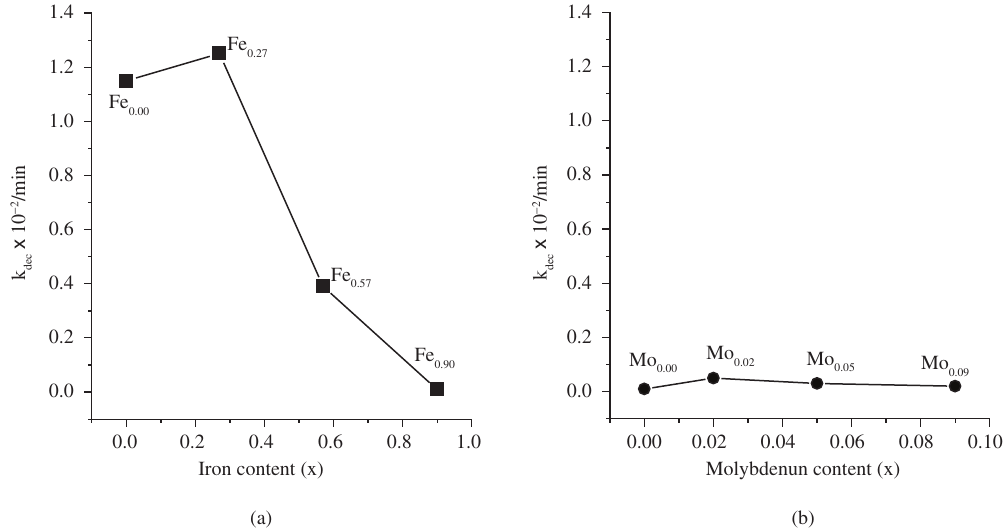
Figure 6. Hydrogen peroxide decomposition rate a) in the presence of perovskite with different concentration of Fe (LaMn tration of Mo (LaMn